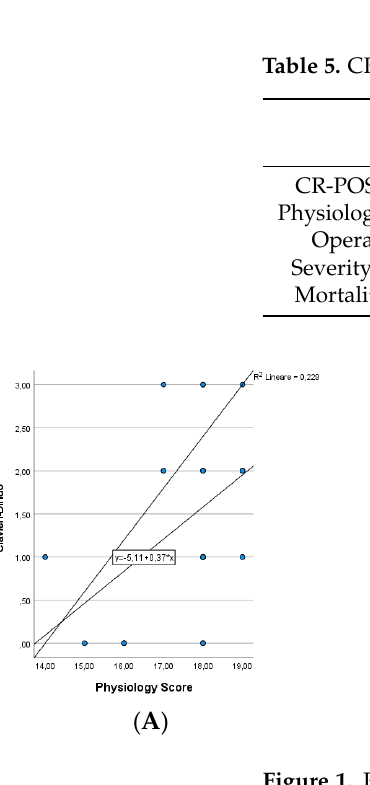
Figure 1. Pearson correlation coefficient to predict postoperative hospital stay. Physiology Score and ( A ) Postoperative Hospital Stay ( ρ = 0.193 p value = 0.289). ( B ) Operative Severity Score and Postoperative Hospital Stay ( ρ = 0.07 p value = 0.703). ( C ) Mortality Rate and Postoperative Hospital Stay ( ρ = 0.269 p value = 0.136).